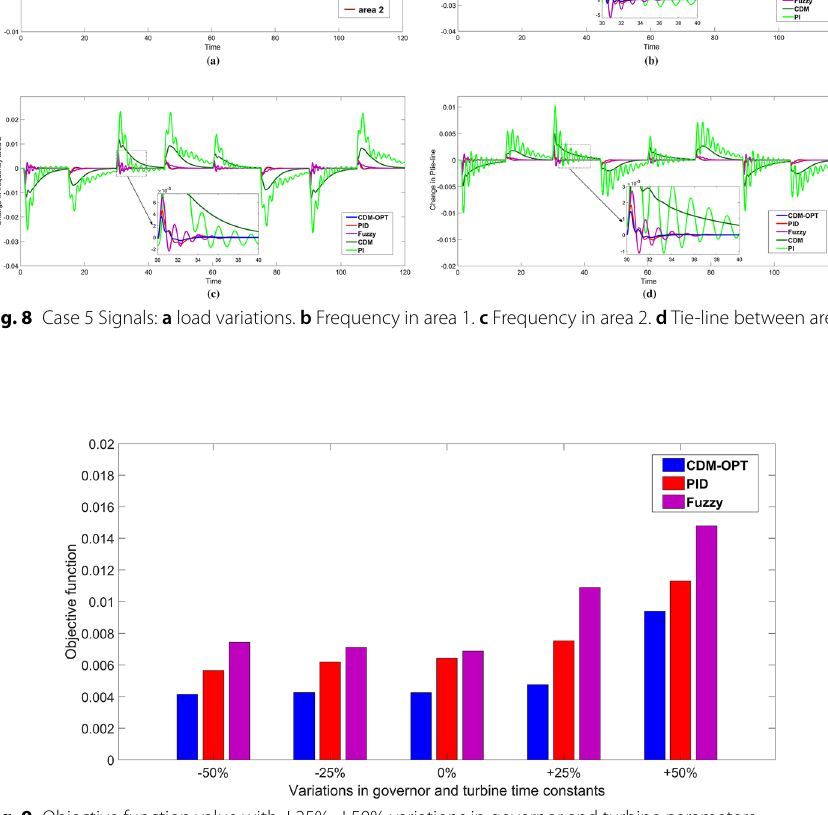
Fig. 9 Objective function value with ± 25%, ± 50% variations in governor and turbine